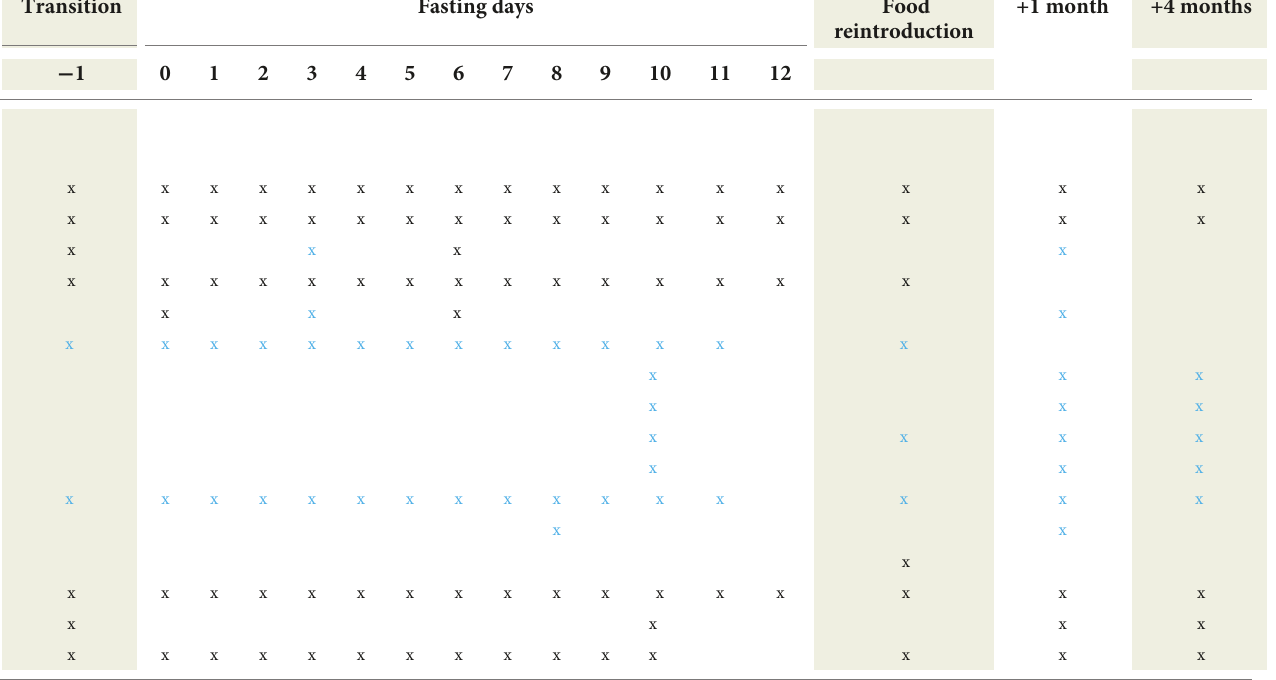
Measurementsonlyconductedinthefirststageofthisstudy( n